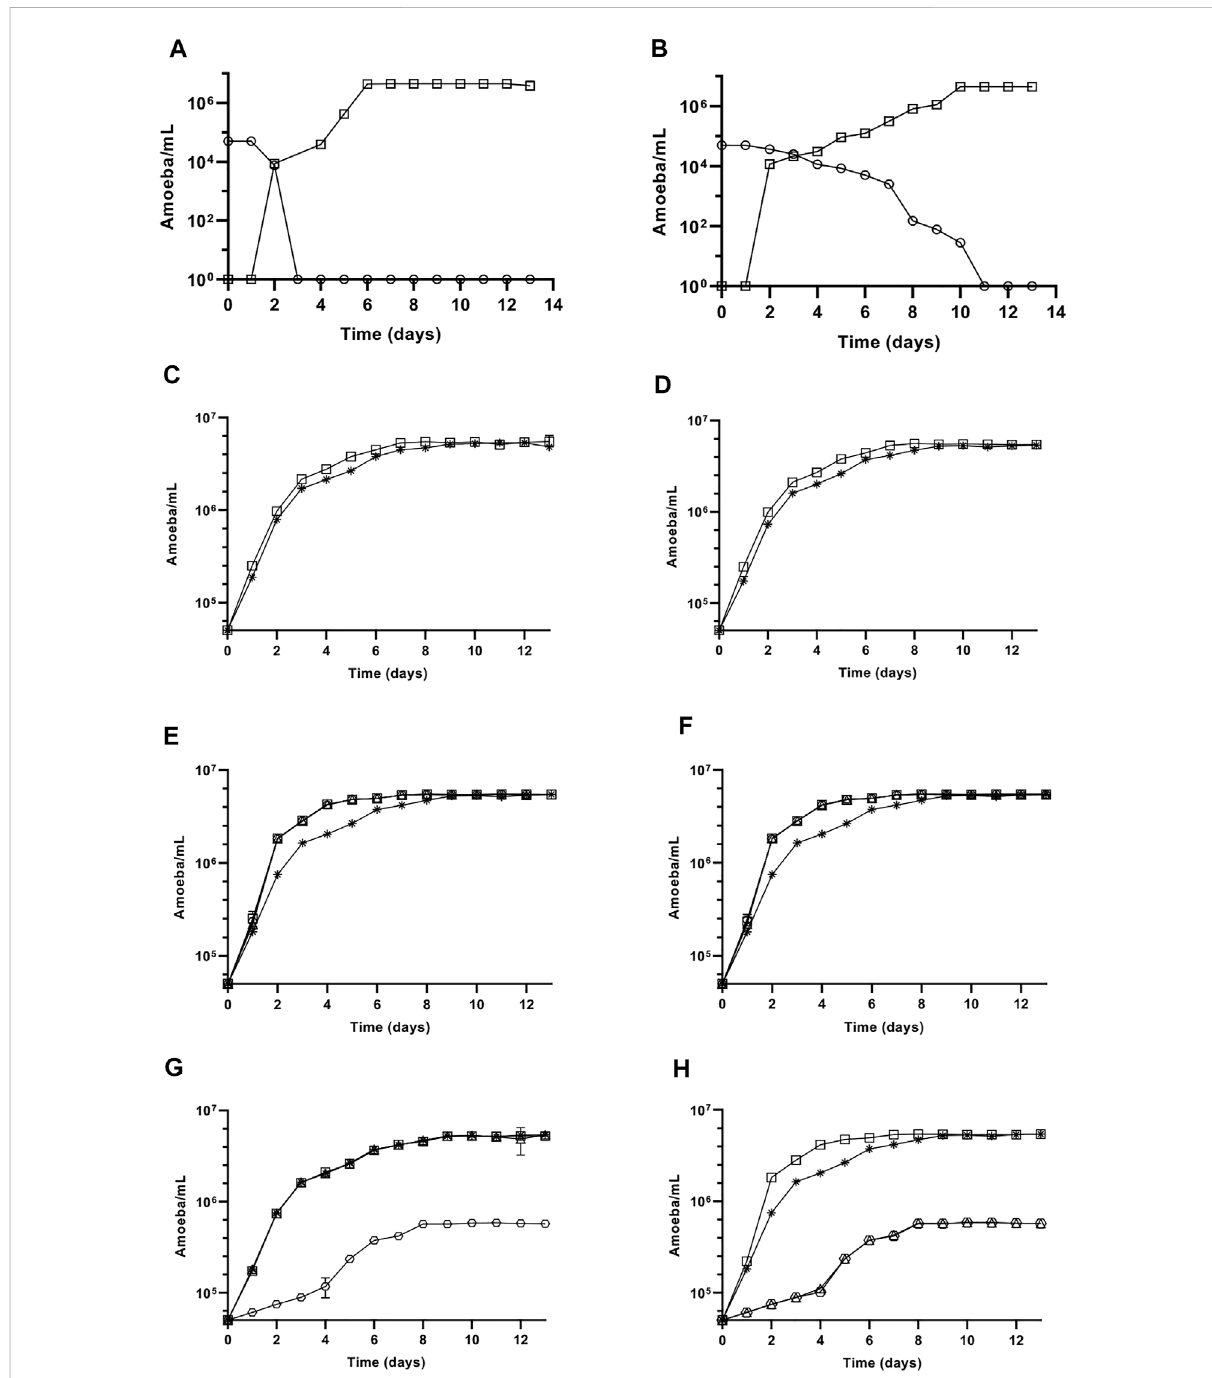
FIGURE 6 In fl uenceofcellulaseandcelluloseon A.castellanii trophozoitegrowthat27 ° C. (A,B) Cyst( ○ )excystmentandtrophozoite( □ )growthkineticsin the presence (A) or absence (B) of 7.5 U/mL cellulase. (C,D) Growth kinetics of trophozoites in the presence ( □ ) or absence (*) of 7.5 U/mL cellulase after a passage following their excystment in the presence (C) or absence (D) of 7.5 U/mL cellulase. (E,F) Growth kinetics of non-freshly excysted, regularlypassed,trophozoitesinPYGmedium alone(*)orPYGmedium supplemented with7.5 U/mLcellulaseand celluloseat1 g/L ( □ ),2.5 g/ L ( △ ) or 5 g/L ( ○ ), either directly to the trophozoites (E) , or pre-incubated 24 h at 27 ° C before adding the amoebae (F). (G,H) Growth kinetics of regularly passed trophozoitesinPYG culture medium alone(*)or PYG medium supplemented with cellulose (G) at1 g/L( □ ), 2.5 g/L ( △ ),or 5 g/L ( ○ ), or with glucose (H) at 50 mM ( □ ), 100 mM ( △ ), or 150 mM ( ○ ). The results correspond to the mean of three independent experiments